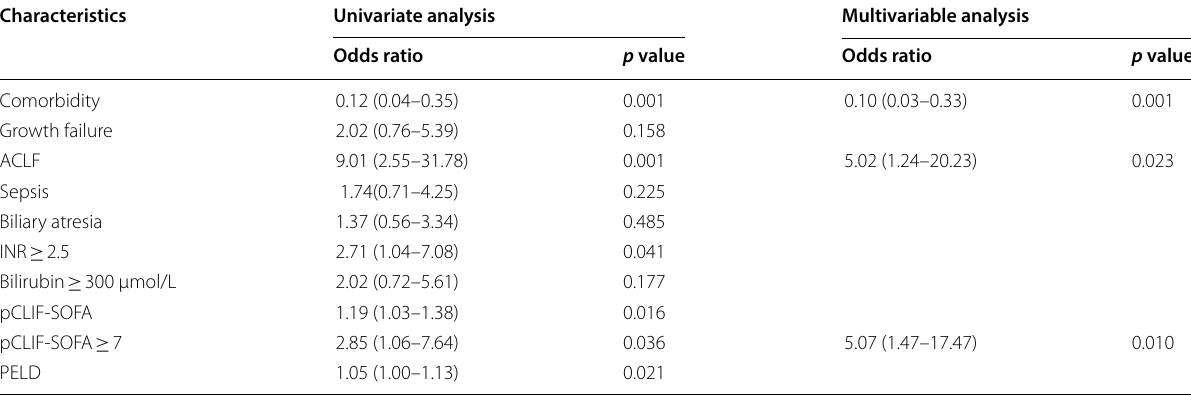
29) versus survival without ( n =